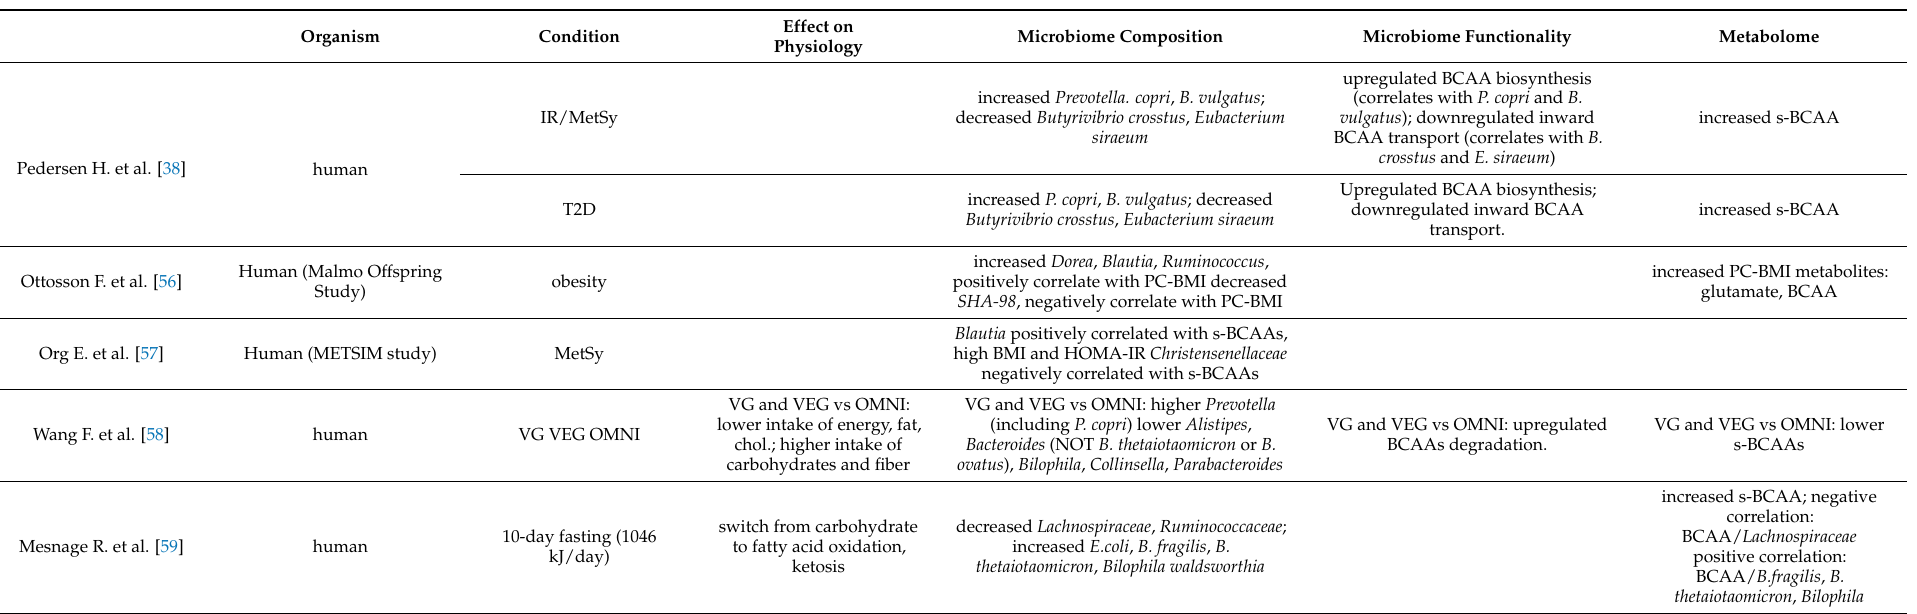
Table 1. Conditions associated with altered circulating BCAA concentration: human